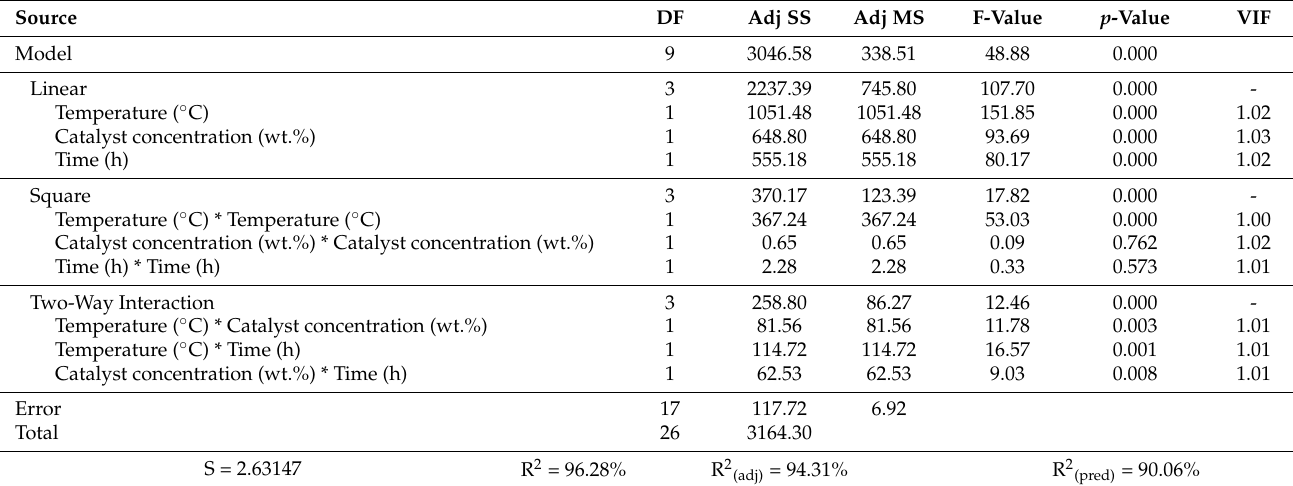
Table 1. ANOVA results for geraniol conversion.